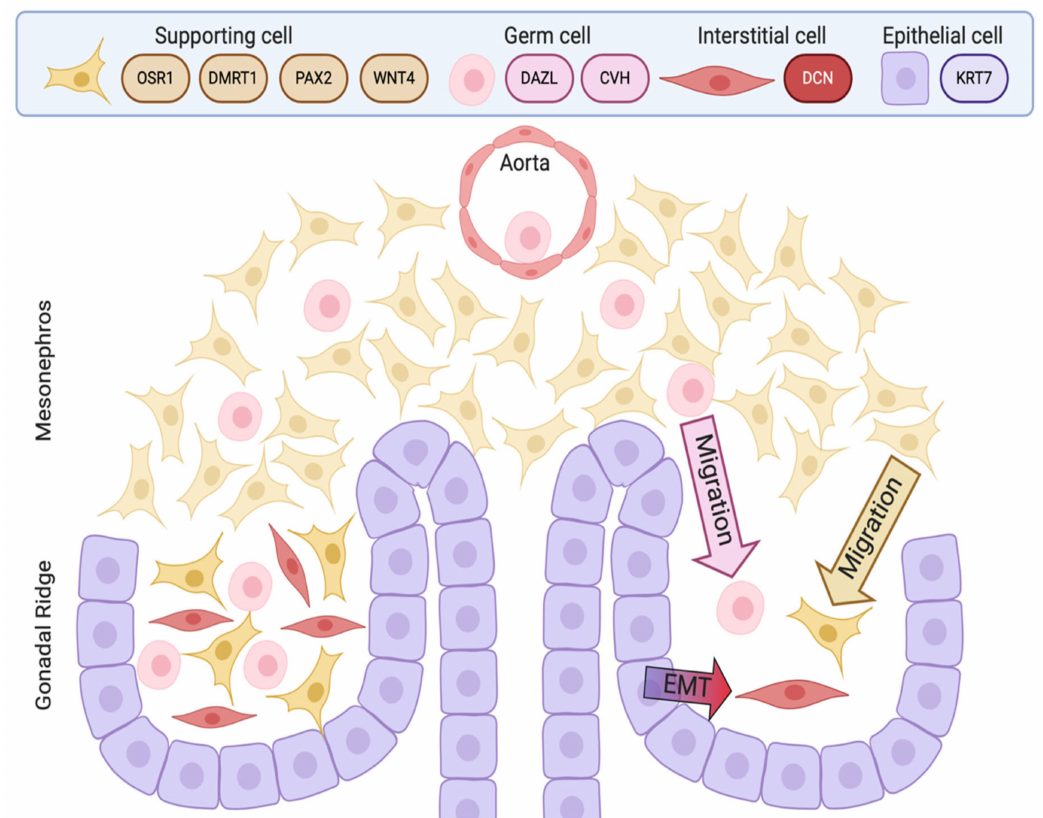
Figure 3. Schematic view of paired gonadal primordia development in the chicken embryo (E3.5- E4.5/stage 19-25). The supporting cell lineage (pre-Sertoli cells in males) derives from a resident mesenchymal cell population expressing PAX2, OSR1, WNT4 and DMRT1 (brown). The DAZL/CVH+ germ cells (pink) migrate into the gonad via the blood stream, exiting the dorsal aorta. The Keratin 7 + (KRT7) gonadal surface epithelium (coelomic epithelium) (purple), generates Decorin + (DCN) non-steroidogenic interstitial cells (red) via an Epithelial to Mesenchyme Transition (EMT), at least at early embryonic stages. image created with